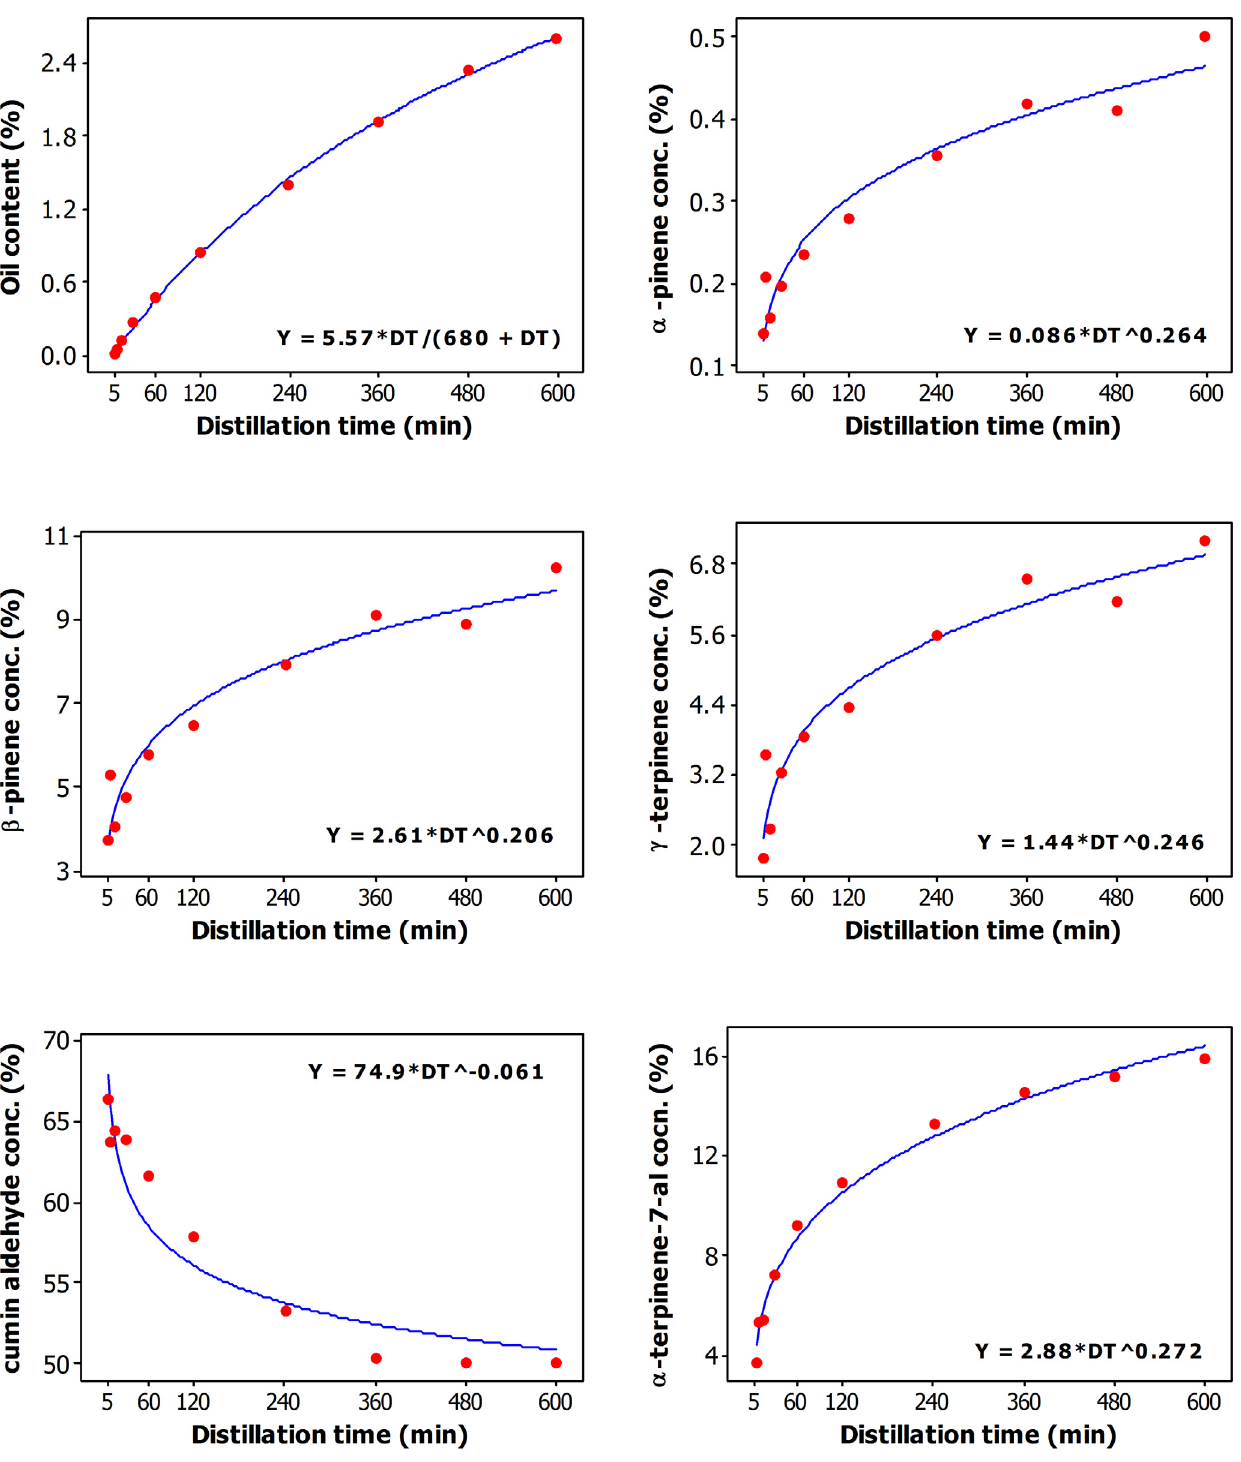
Fig 2. Plot of Distillation time vs oil content (%), and concentration (%) of α -pinene, β -pinene, γ -cymene, γ -terpinene, cumin aldehyde, α -terpinen- 7-al, and β -terpinen-7-al along with the fitted (solid line) Michaelis-Menten and Power models.